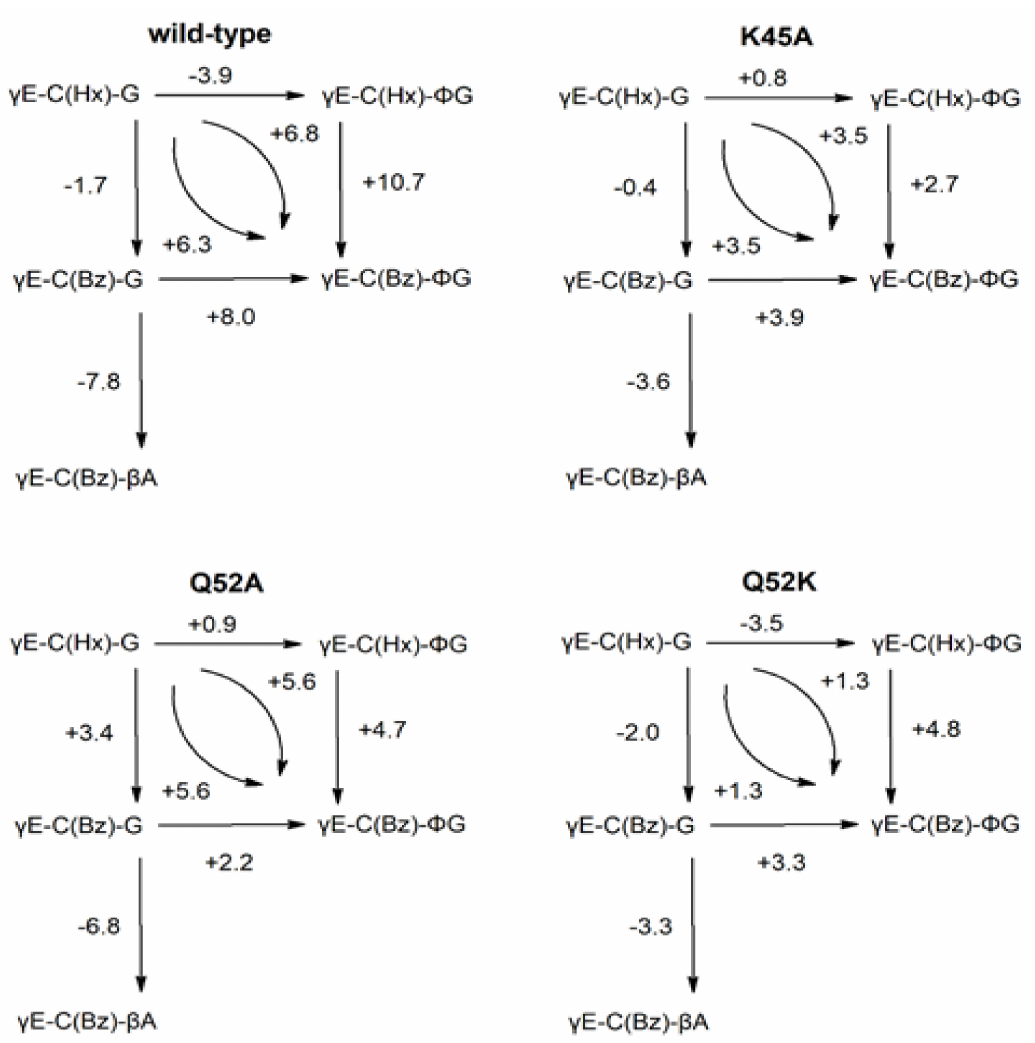
Figure 3. Schemes of incremental binding energies (kJ mol − 1 ) in comparison of the binding of five di ff erent glutathione derivatives to wild-type GST P1–1 and mutants K45A, Q52A, and Q52K. The complexes with S-hexylglutathione, γ E-C(Hx)-G (upper left corners) serve as references. Positive values indicate increased binding a ffi